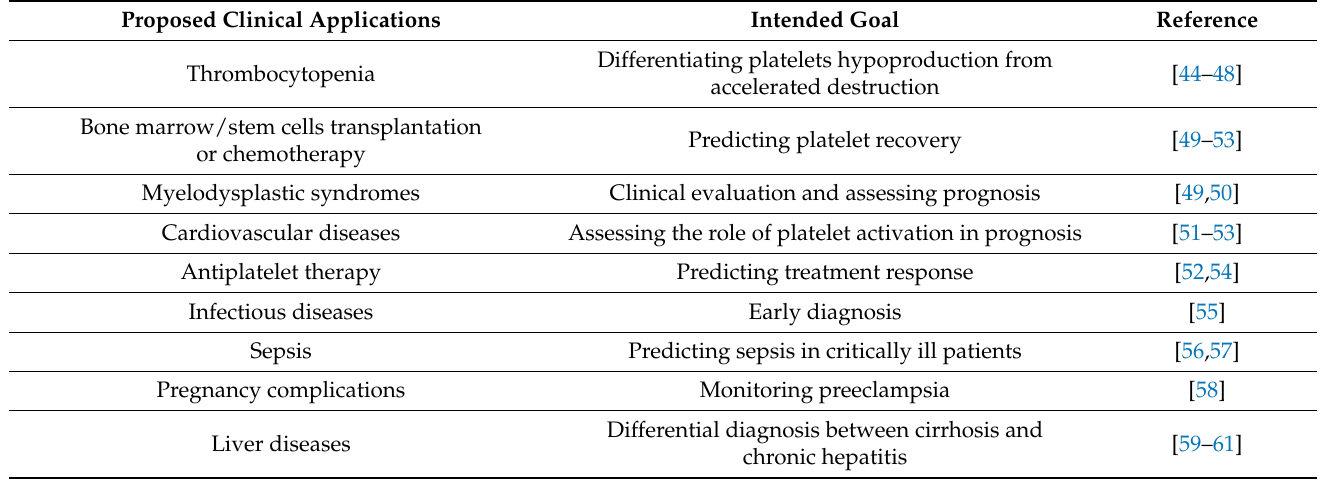
Table 2. Clinical applications of IPF and